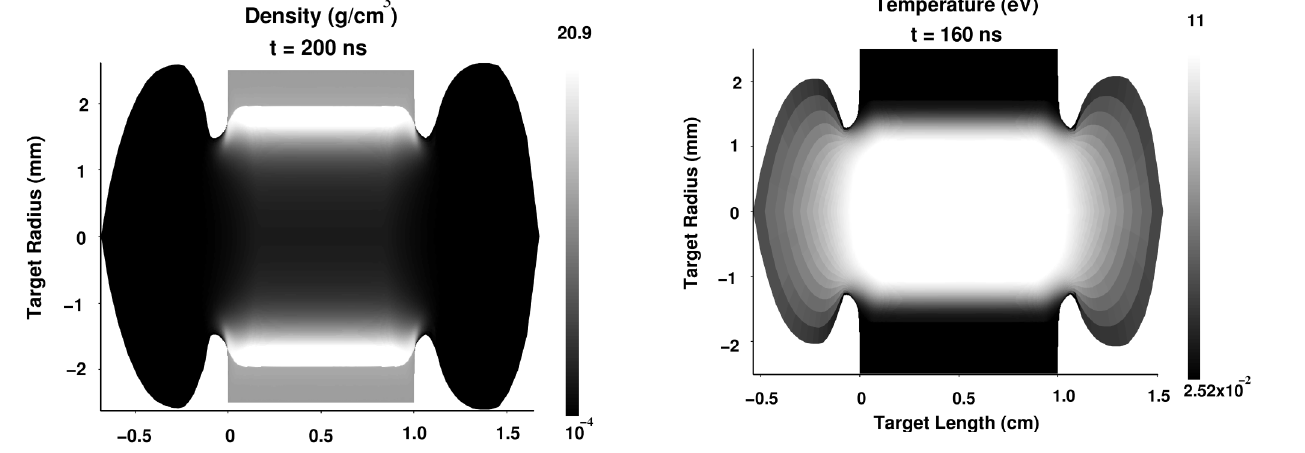
FIG. 11. Temperature at t (cid:3) 160 ns corresponding to the case shown in Fig. 5.